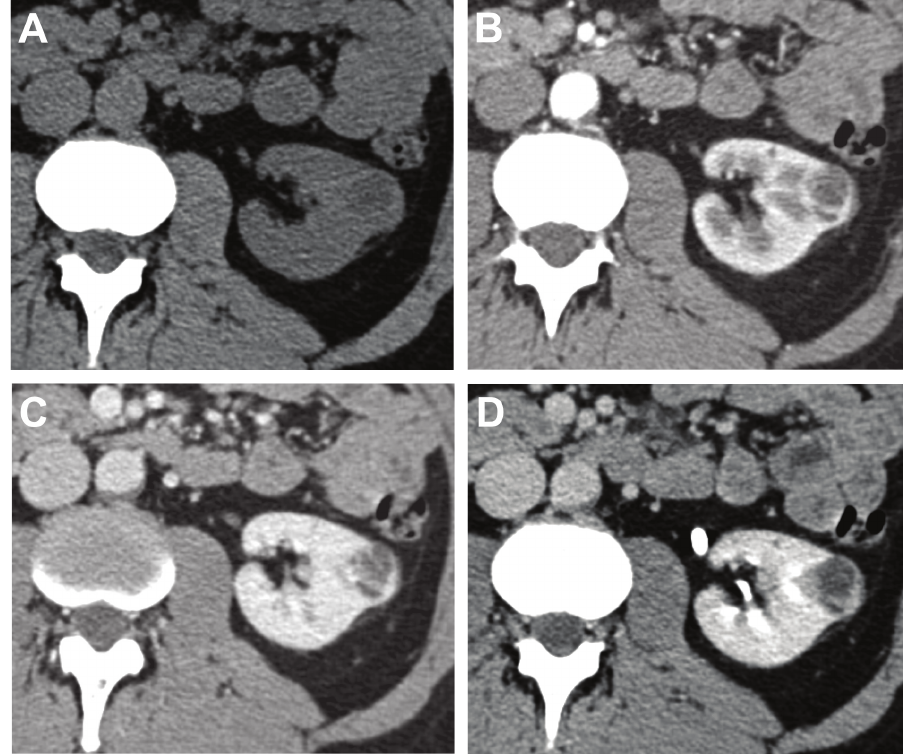
Figure 3. Unenhanced CT axial scan (a), CT axial scan during arterial (b), venous (c), and nephrographic (after 180 seconds from the contrast medium injection) (d) phases of a 44-year-old male, showing the presence of an oval, partially esophytic lesion with predominantly fl uid-corpusculated content and internal septa. Cytological and histological examination have placed the diagnosis of clear cell renal cell